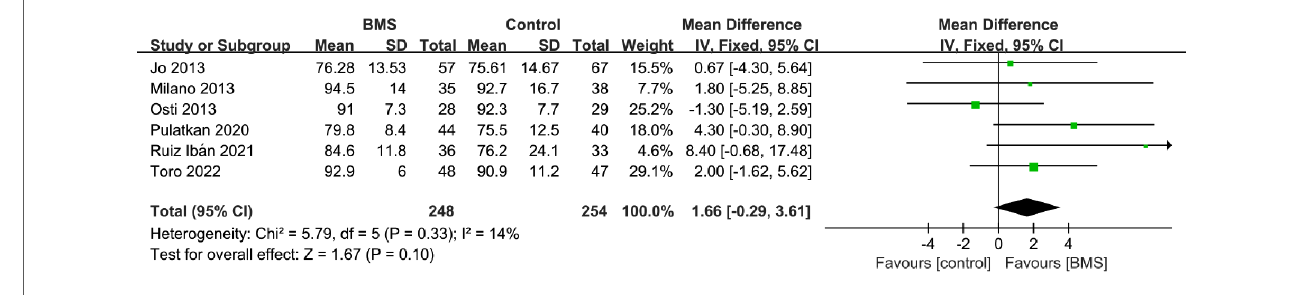
FIGURE 4 Forest plot comparing postoperative constant scores between the BMS and control groups.